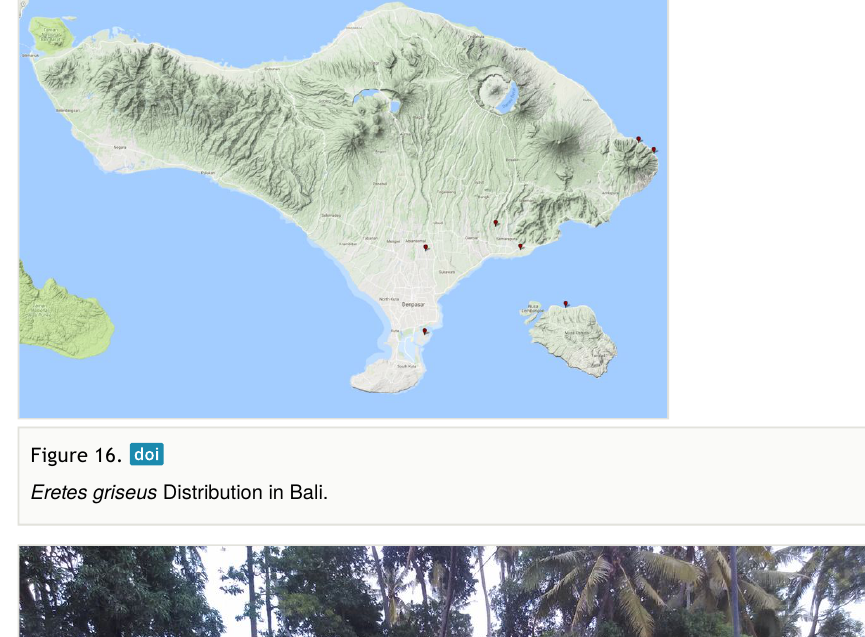
Figure 16. Eretes griseus Distribution in Bali.